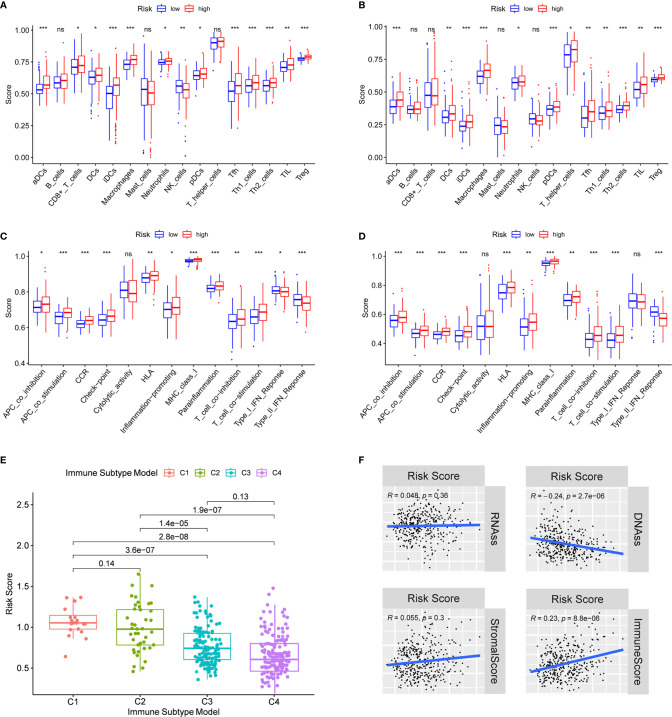
Immune status between different risk groups and the association between risk score and tumor microenvironment. TCGA cohort (A, C), ICGC cohort (B, D). (A, B) The scores of 16 immune cells and (C, D) 13 immune-related functions were showed in boxplots. (E) Comparison of the risk score in different immune infiltration subtypes. (D) The relationship between risk score and RNAss, DNAss, Stromal Score and Immune Score. P values were showed as: ns, not significant; *P < 0.05; **P < 0.01; ***P < 0.001.